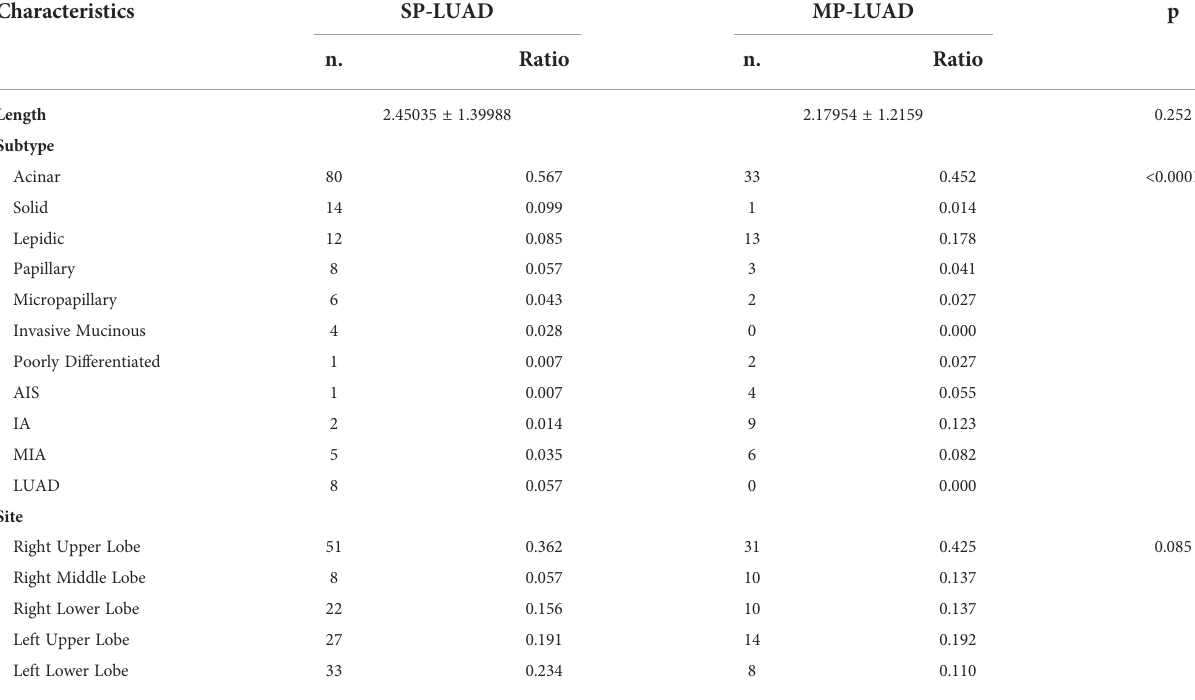
TABLE 2 Pathological correlation analysis.